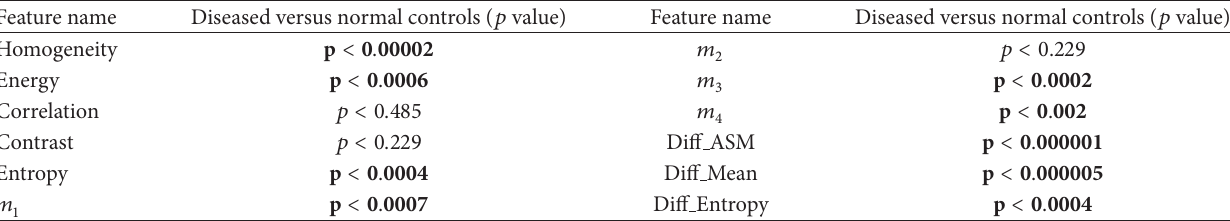
Table 3: ANOVA (1 within-subject factor) results summary of statistics 𝑝 value for patients (either edema or cancer) Haralick texture features versus normal controls.